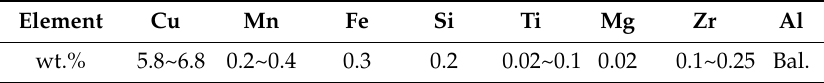
Table 1. Composition of the 2219 aluminum alloy.